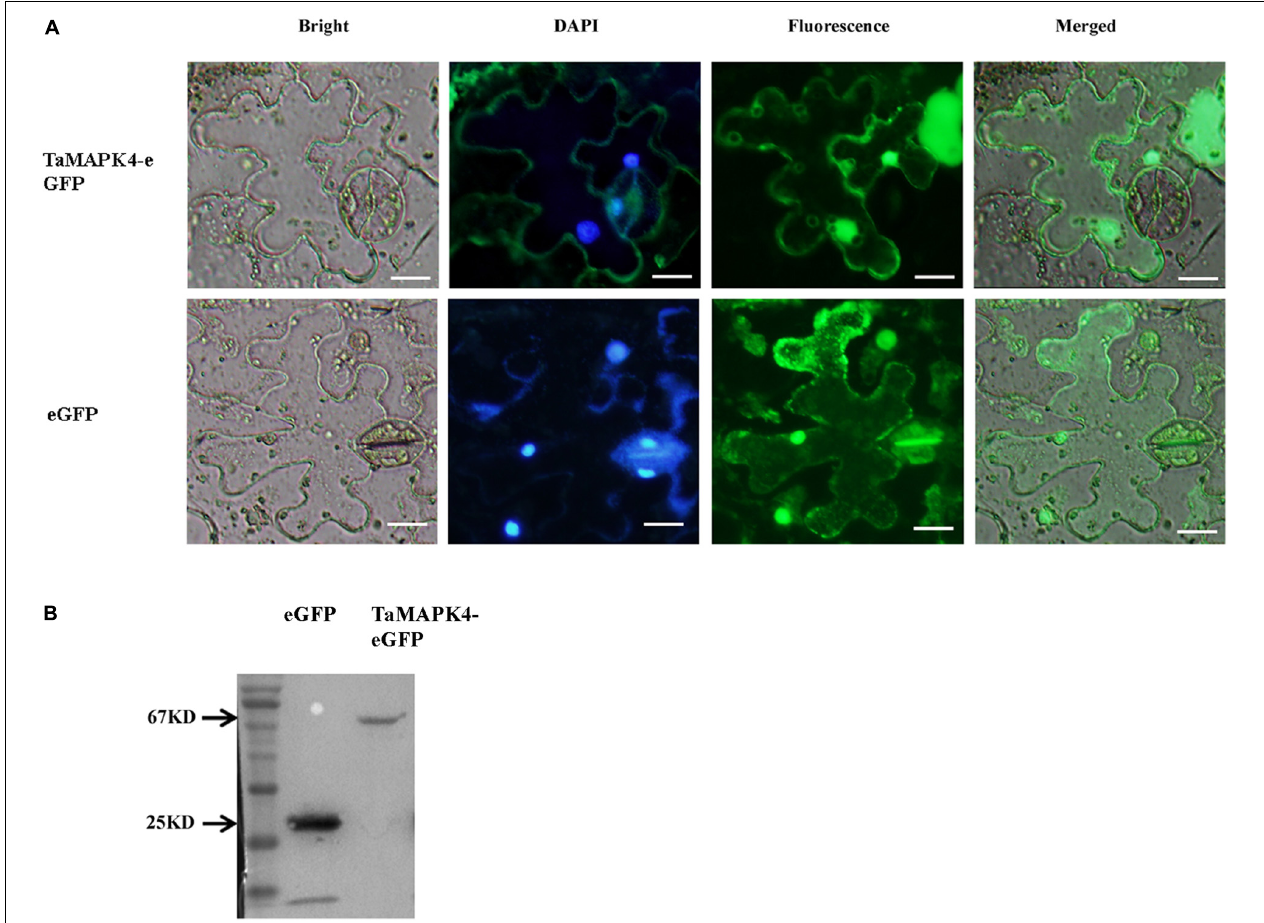
FIGURE 2 | Subcellular localization of TaMAPK4 protein. (A) TaMAPK4-GFP fusion protein and green fluorescent protein (GFP) (control) were transiently expressed in N. benthamiana . (B) Western blot analysis of GFP and TaMAPK4-GFP fusion protein. Bar = 20 µ m. Similar results were obtained from three biological